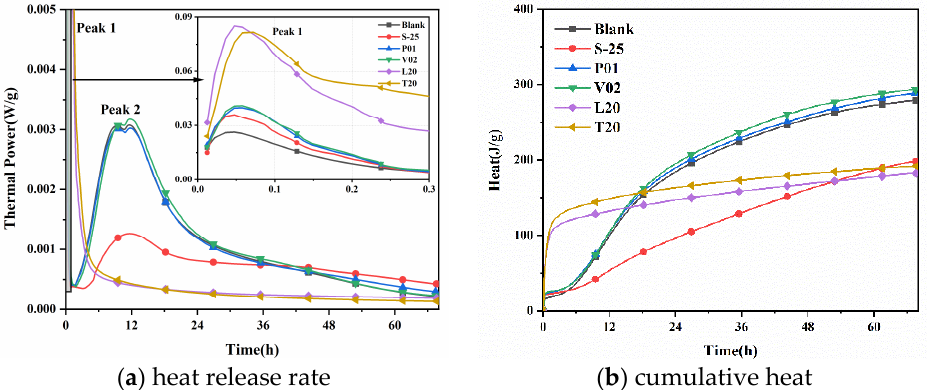
Figure 11. Effect of different interface agents on hydration heat of cement.